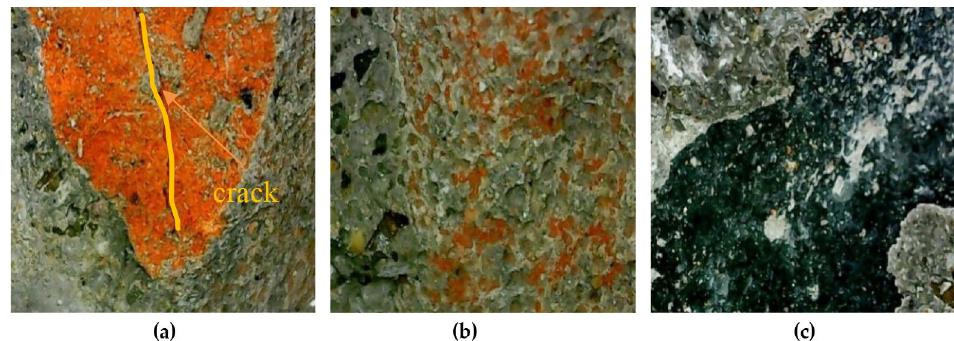
Figure 7. General microscope observation chart: (a) Red brick aggregates; (b) mortar; (c) Natural coarse aggregates.